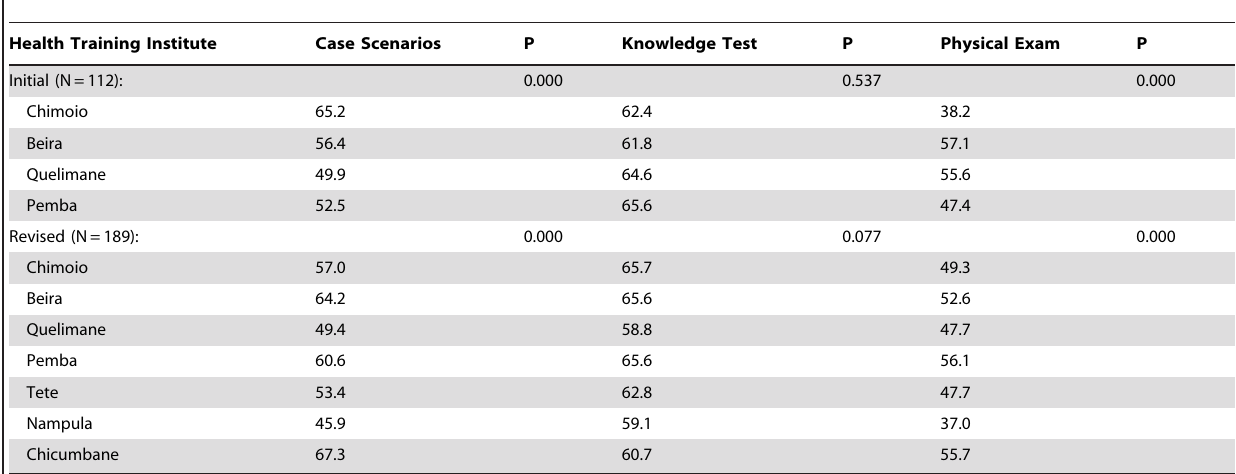
Table 5. Results* from comparison of means (average scores) between schools by curriculum